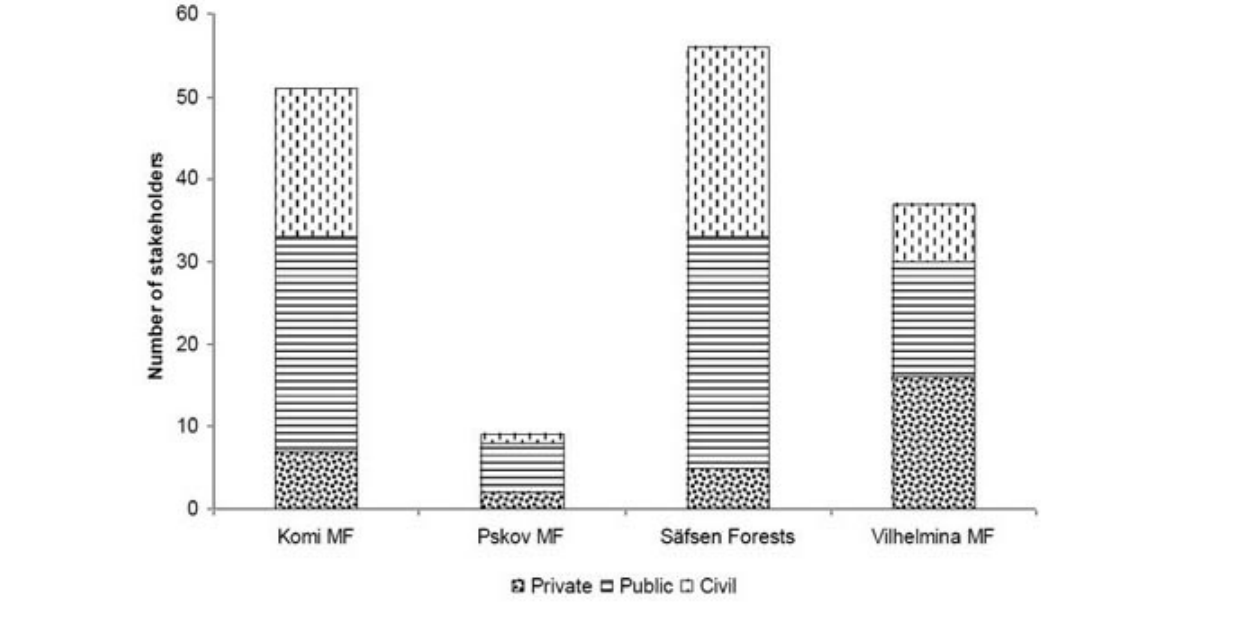
Fig. 2. The relative number of stakeholders in three societal sectors involved in multi-stakeholder collaboration in Russian and Swedish MF initiatives (in a number of stakeholders in each